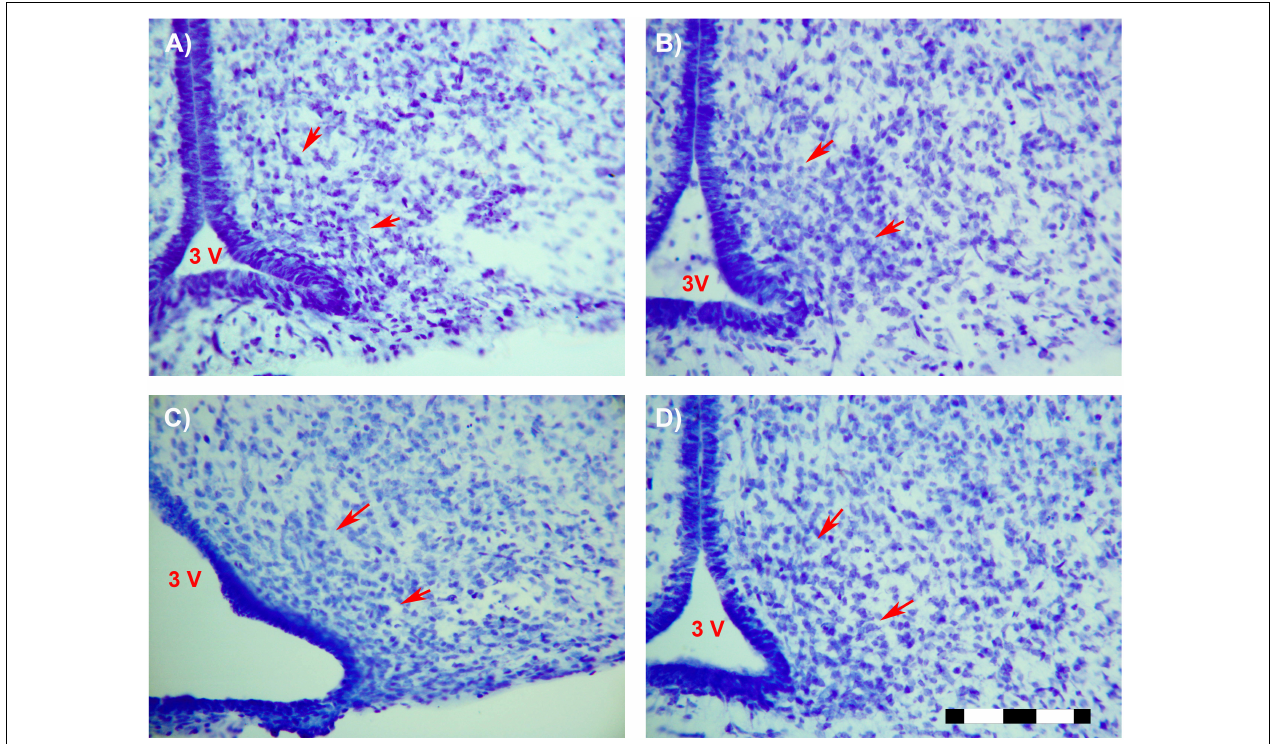
FIGURE 2 | Photomicrographs ( × 25) showing the sexual dimorphism found between LPCM and LPCF. Limits of the ARC are signaled by red arrows. (A) CF; (B) CM; (C) LPCF; (D) LPCM. CM, control male; CF, control female; LPCM, low-protein and low caloric male; LPCF, low-protein and low caloric female. Bar = 100 µ m (Paxinos et al.,